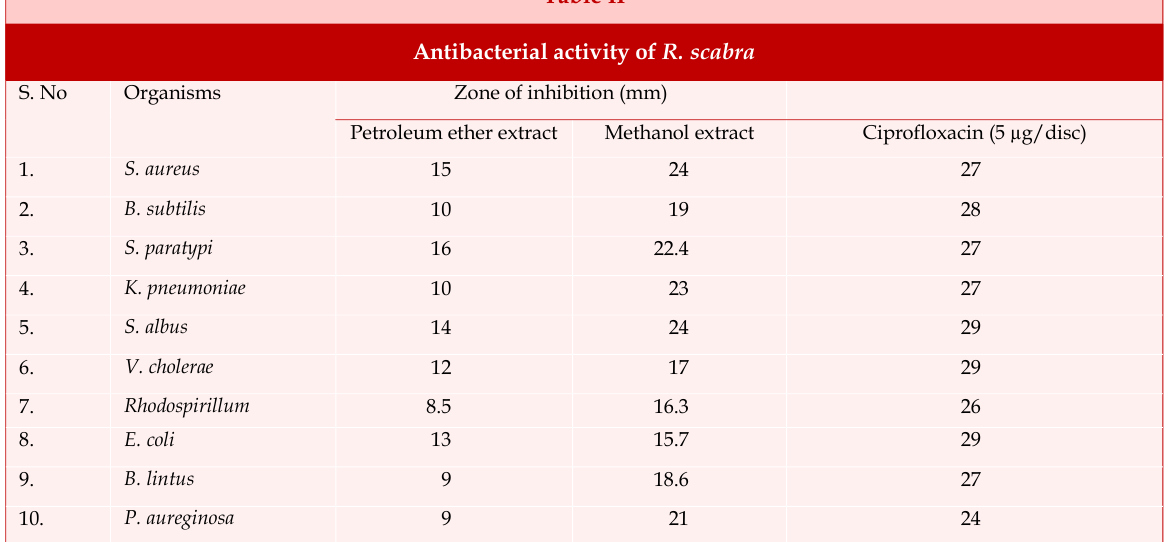
Antibacterial activity of R.